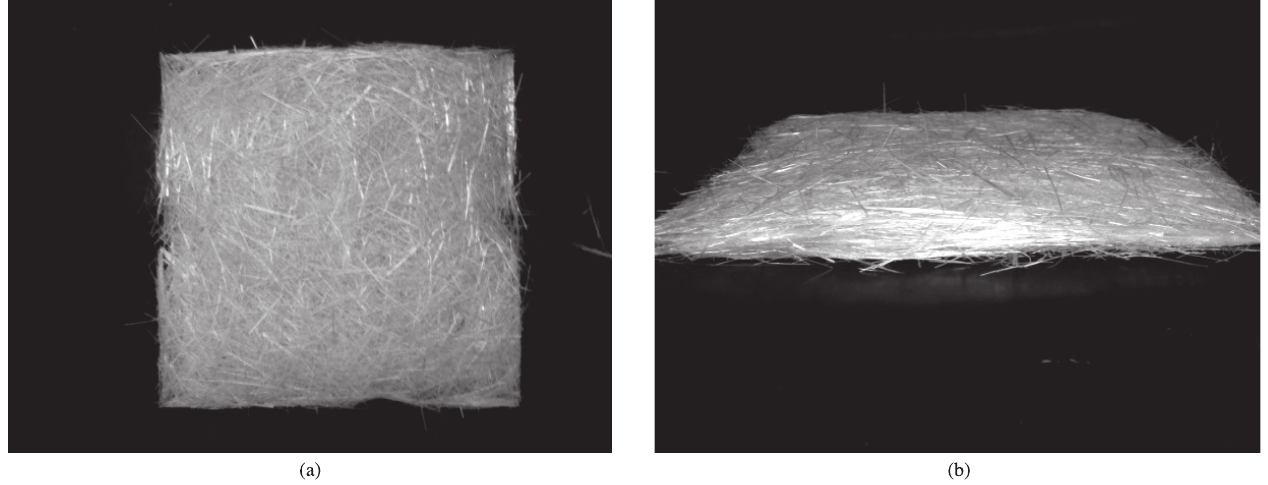
Figure 5. Hybrid mat (50% glass fiber / 50% sisal fiber) manufactured with the aqueous method: (a) superior view and (b) side view.